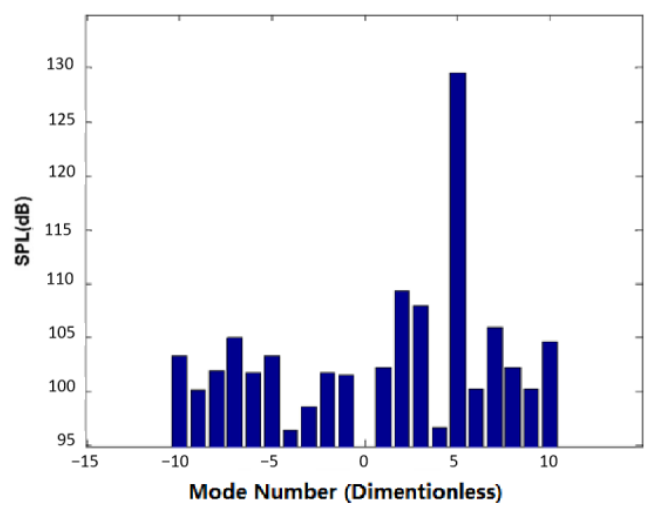
Figure 8. (3, 0) circumferential modes result at 1250 Hz.